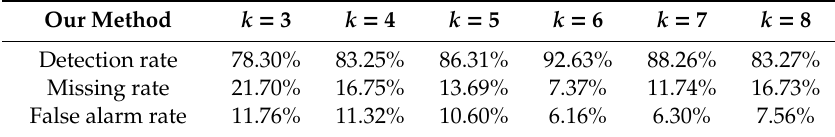
Table 3. Detection performance of di ff erent k on UNM_live_lpr data.